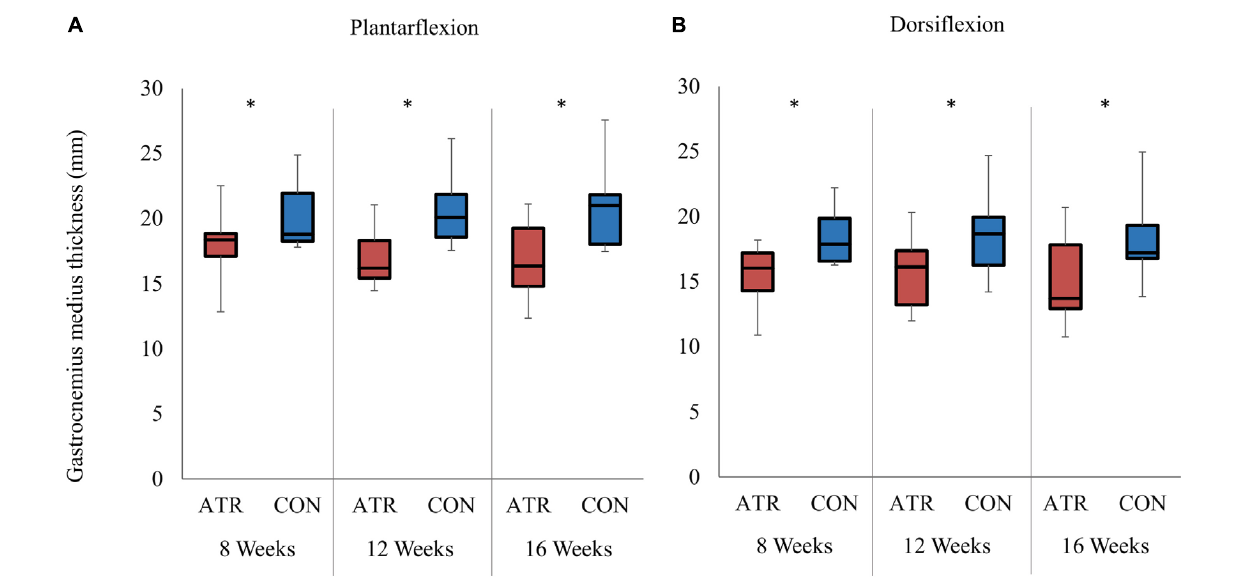
FIGURE 2 | Medial gastrocnemius muscle thickness on the ATR-injured and contralateral limbs at maximal plantarflexion (A) and dorsiflexion (B) . Significant levels for the overall effect of leg type as determined by a factorial repeated-measures ANOVA ( p < 0.01) are indicated with